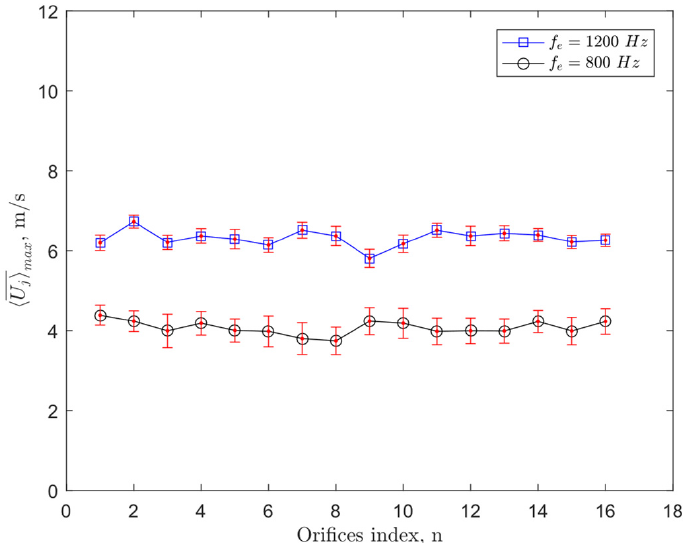
Figure 8. Variation of the time–mean jet velocity during expulsion stroke along the array of orifices at Y/D = 1 (measured at each orifice centreline) for two representative excitation frequencies ( f e = 800 Hz and 1200 Hz) for the case with compartmented cavities.